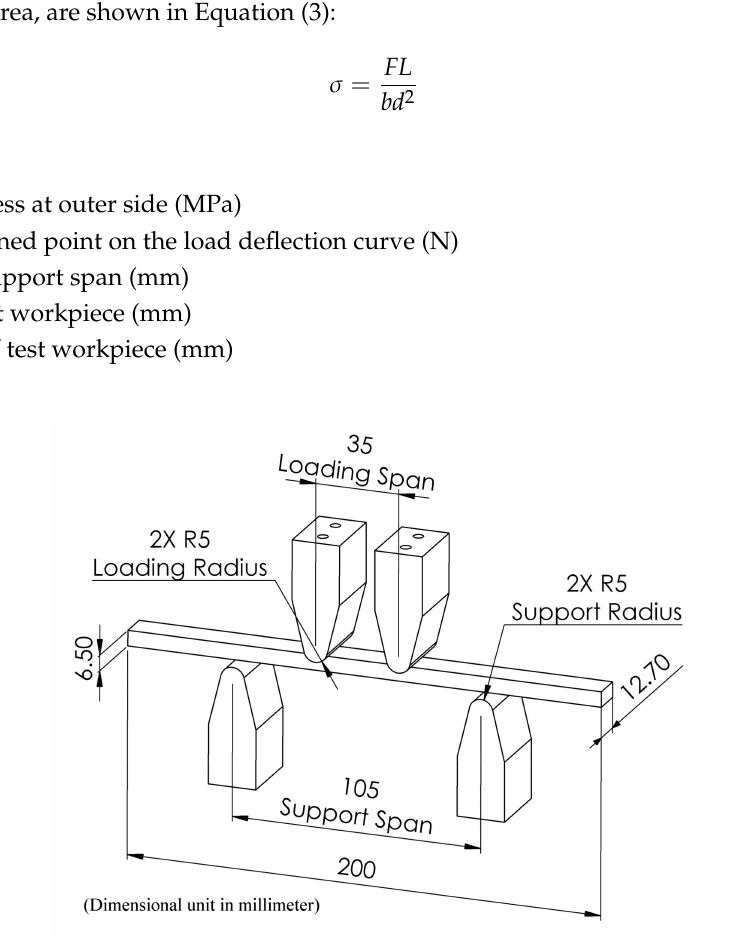
Figure 8. Test workpiece detail of American Society for Testing and Materials (ASTM)